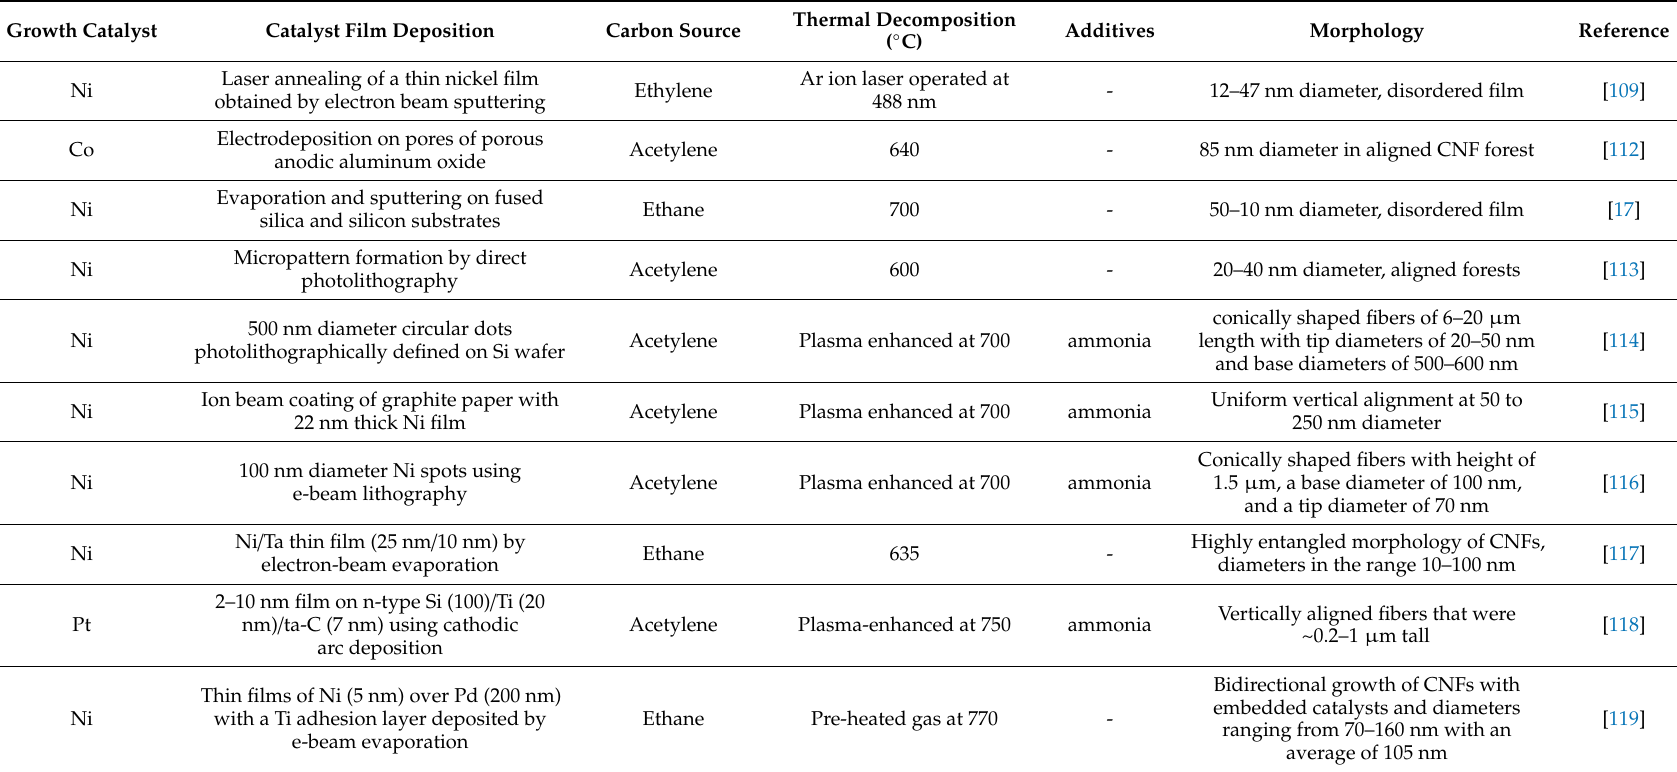
Table 2. Summary of the preparation methods of carbon nanofiber films on macro-structured supports by chemical vapor deposition. Growth